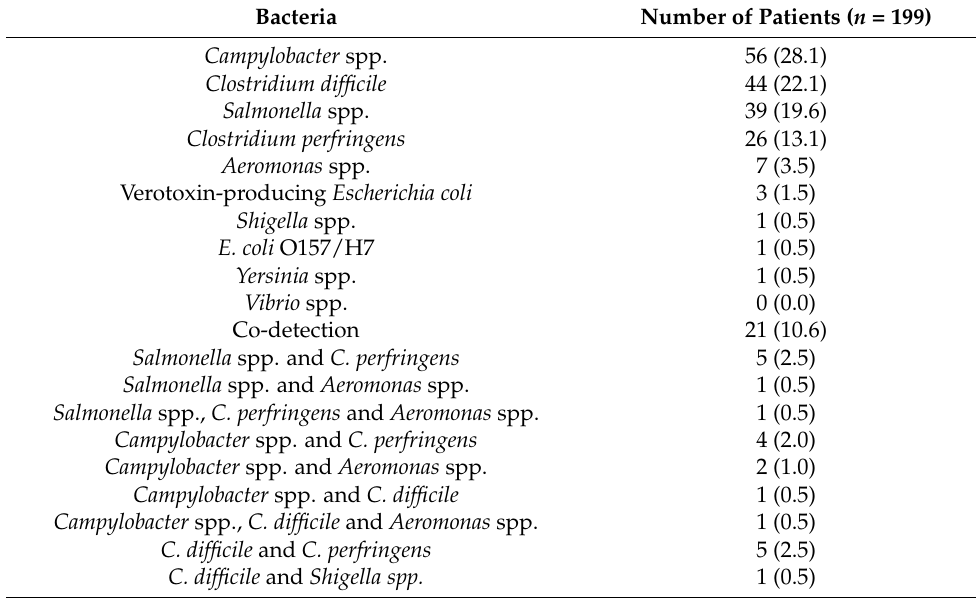
Table 1. Distribution of pathogenic bacteria identified by bacterial multiplex polymerase chain reaction